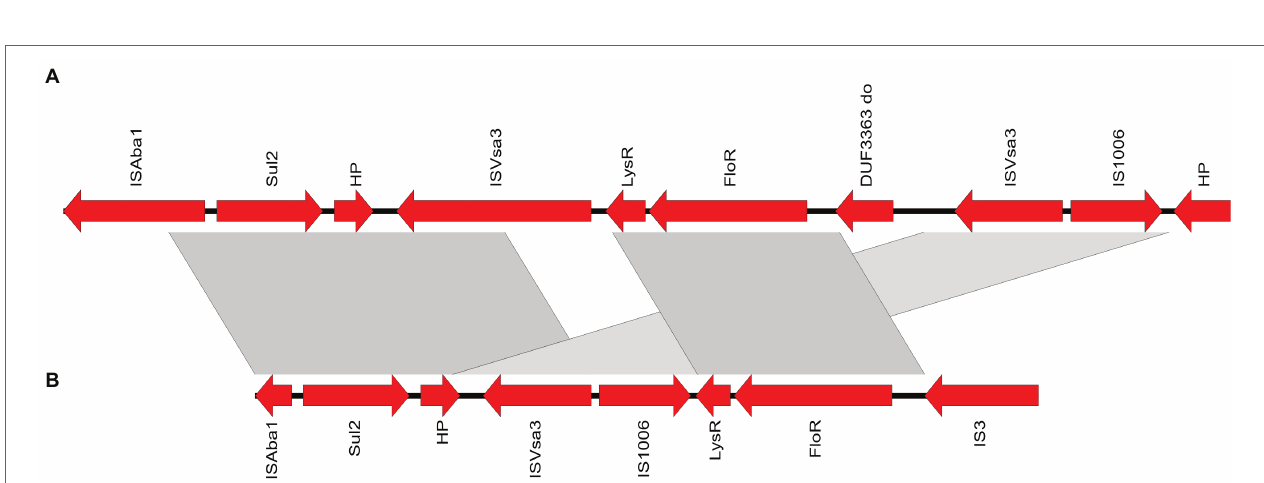
FIGURE 5 | Gene maps showing the genetic environment of IS1008 -interrupted bla ADC carried by M11 (A) compared to A. baumannii ACN21 chromosome (GenBank accession: CP038644.1) (B) . ORFs orientation is indicated by arrows. Blue bands between panels indicate inverted sequences with more than 98% sequence similarity. Genes are labelled by their protein products; ADC, bla ADC gene disrupted by IS6; SP, signal peptide.